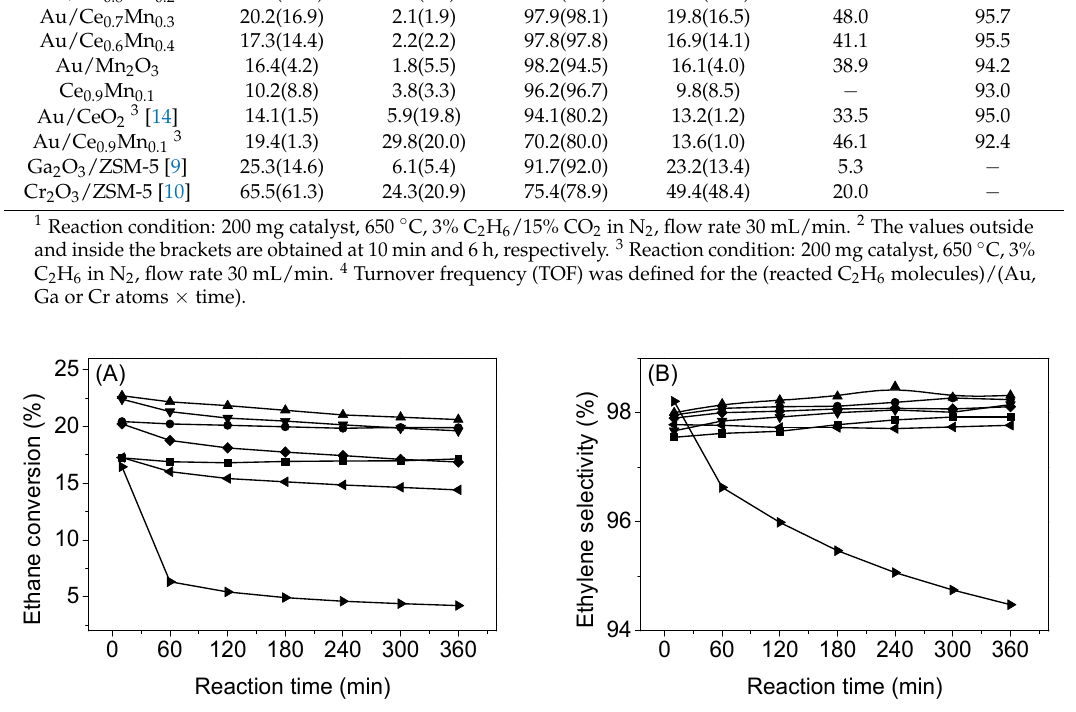
Figure 5. Ethane conversion (A) and ethylene selectivity (B) over various Au catalysts in the presence of CO 2 :( ■ ) Au/CeO 2 ; ( ● ) Au/Ce 0.95 Mn 0.05 ; ( ▲ ) Au/Ce 0.9 Mn 0.1 ; ( ▼ ) Au/Ce 0.8 Mn 0.2 ; ( ◆ ) Au/Ce 0.7 Mn 0.3 ; ( ◄ ) Au/Ce 0.6 Mn 0.4 ; ( ► ) Au/Mn 2 O 3 . Table 3. Reaction data in the DHE in the presence of carbon dioxide 1